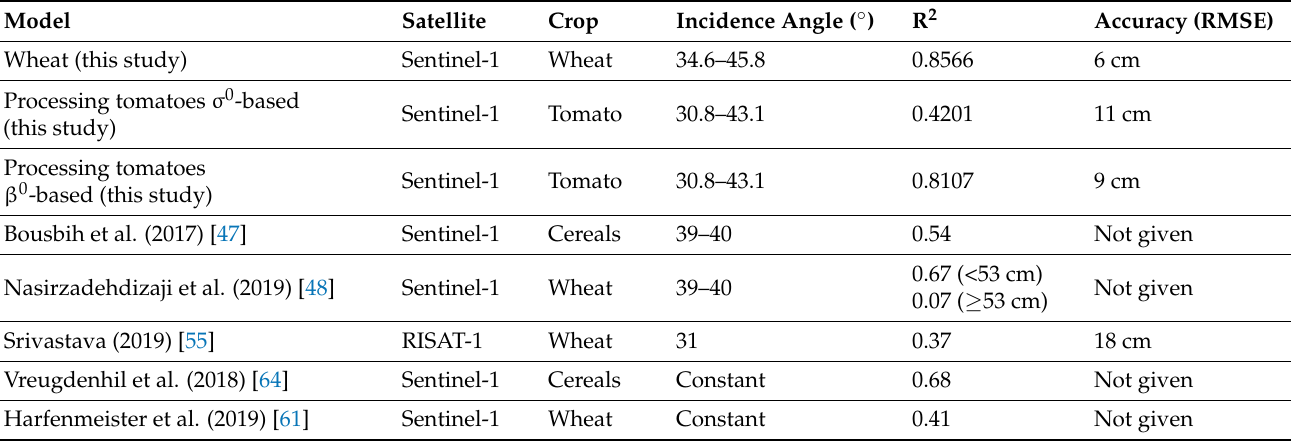
Table 5. Comparison of vegetation height estimation models based on Sentinel-1 and RISAT-1 C-band SAR.